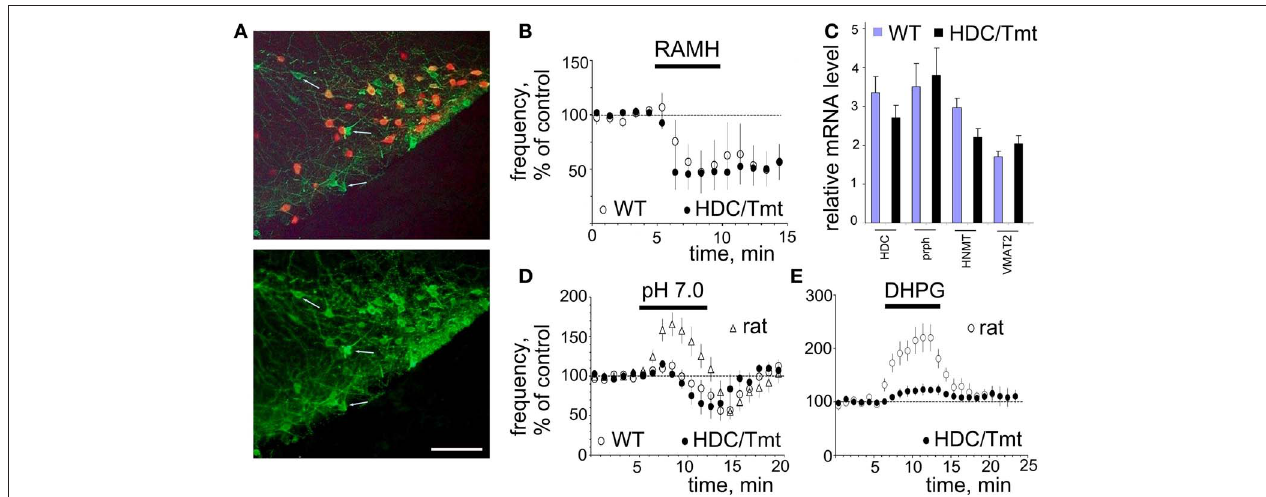
region of 4 WT and 6 HDC/Tmt mice. HDC, histidine decarboxylase; prph, peripherin; HNMT, histamine N -methyl-transferase; VMAT2, vesicular monoamine transporter 2. (D) Acid-induced excitation is hardly seen in mouse WT ( n = 6) or Tmt + ( n = 6) TMN neurons. Data points are superimposed to the time course diagram of acid-induced excitation from rats ( n = 23). (E) The metabotropic glutamate receptor agonist DHPG